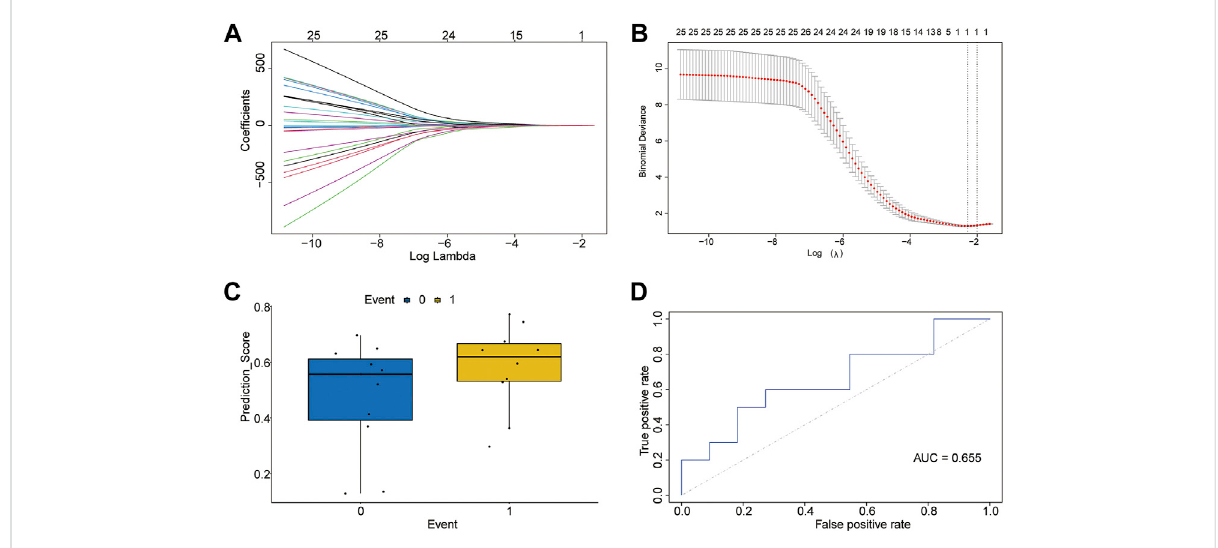
FIGURE 3 Diagnostic modelof m5C-related genes. (A) LASSO regressioncurve. (B) Curve for selection oflambda value. (C) Predicted effect oftheLASSO regression model (T2D = 1, control = 0). (D) Receiver operating characteristic curve of the logistic model for diagnosis of T2D.